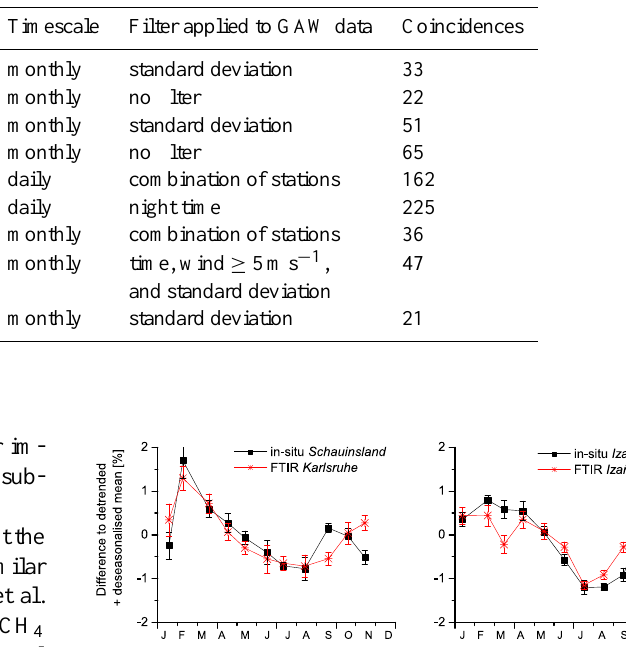
Figure 9. Seasonal cycle for Karlsruhe (left graph) and Izaña (right graph) stations obtained by NDACC FTIR (red stars) and in situ GAW CH 4 mole fraction (black squares),